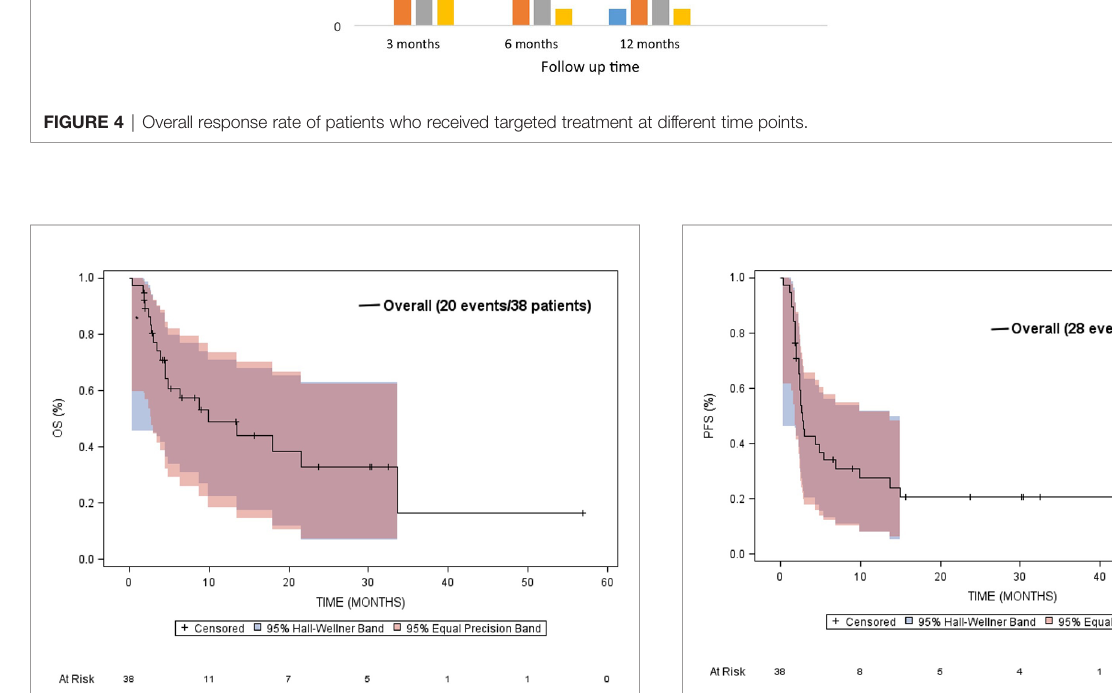
FIGURE 6 | Kaplan-Meier estimated progression free survival (PFS) in patients treated with targeted